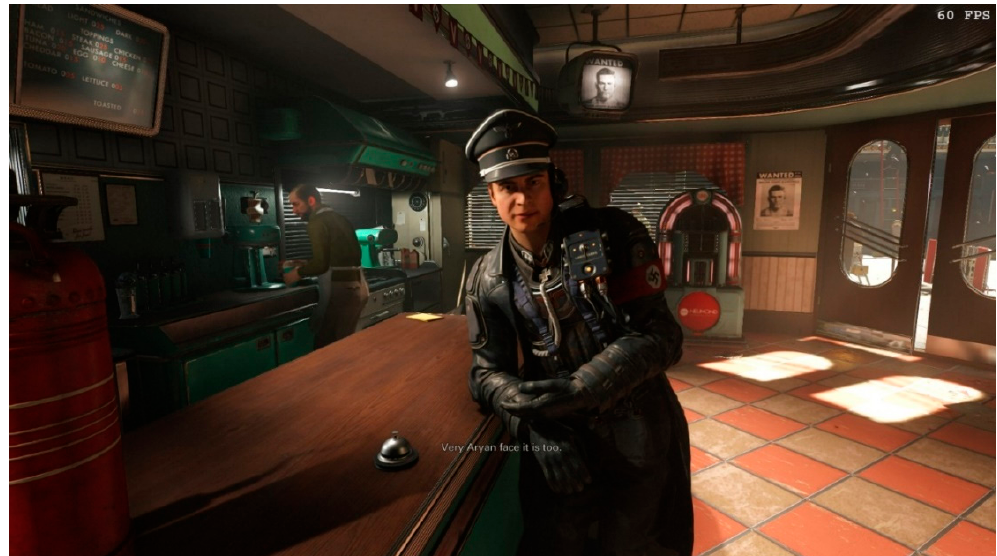
Figure 2. A Nazi officer complimenting the player character upon his Aryan facial features.